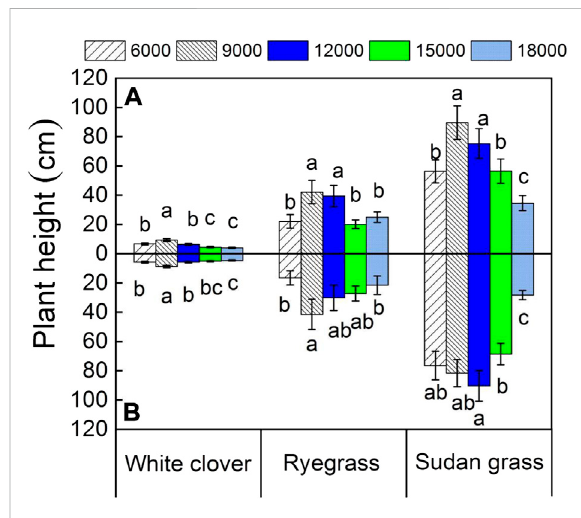
FIGURE 3 Biomass under different petroleum hydrocarbons concentrations. The values shown are the mean ± SE ( n = 3). The same letters among speci fi c treatments are not signi fi cantly different according to Duncan ’ s (0.05). Thus, (A) : treatment without glycine; (B) : treatment with glycine. 6000, 6000 mg kg − 1 petroleum hydrocarbons contaminated soil; 9000, 9000 mg kg − 1 petroleum hydrocarbons contaminated soil;